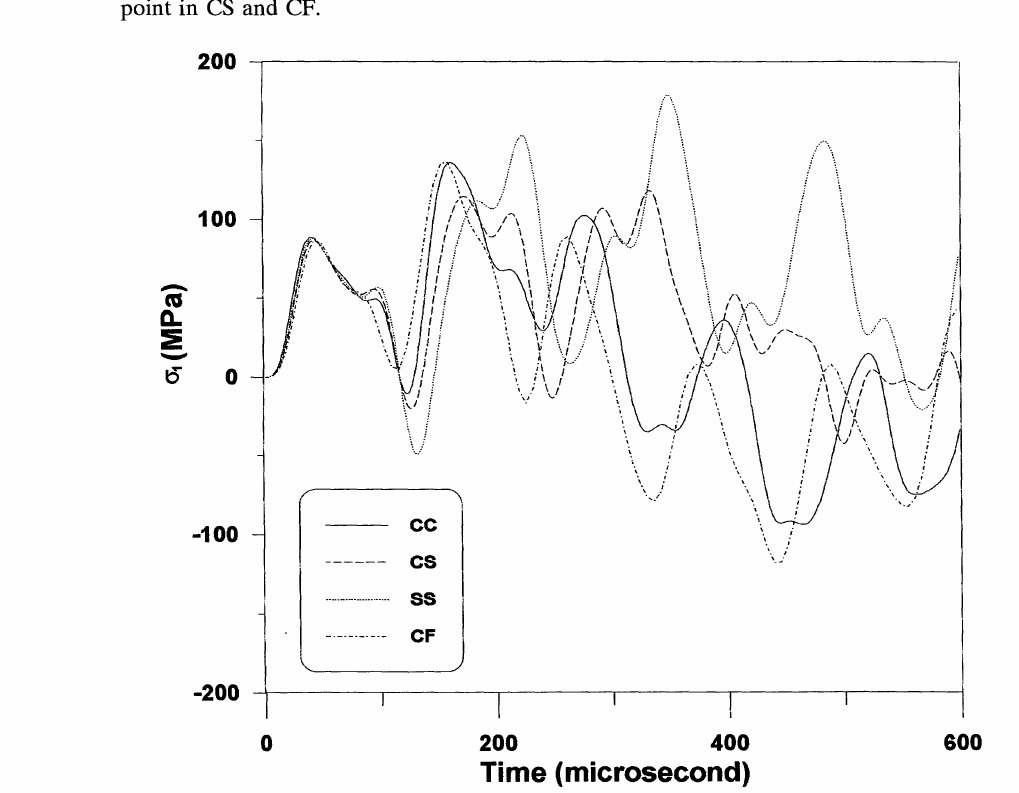
FIGURE 14 The histories of the inplane stresses in CC, CS, SS, and